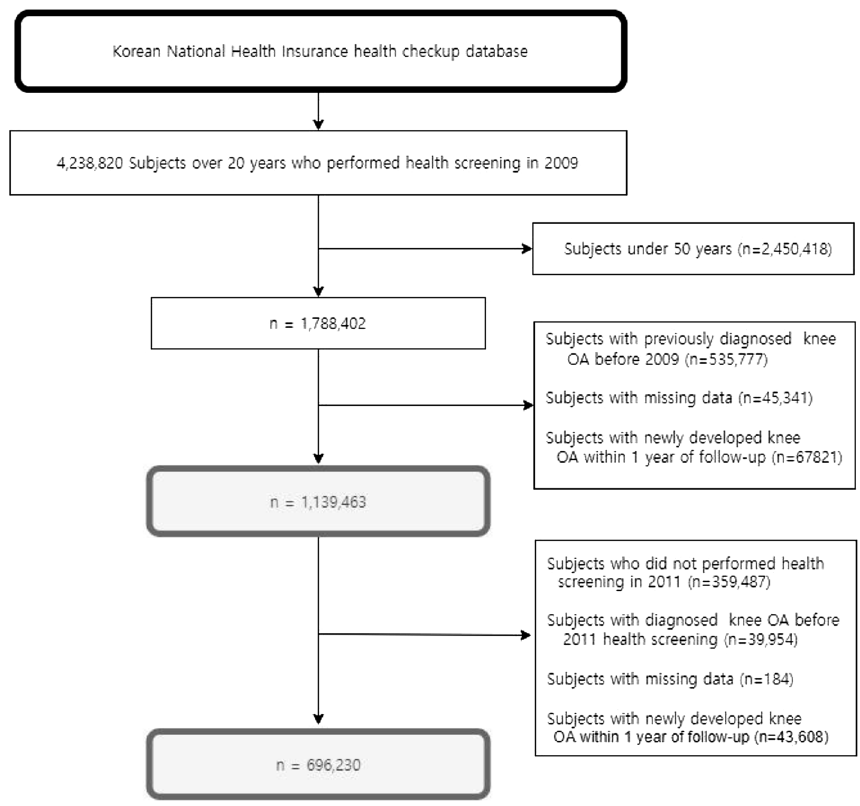
Figure 1. Flow chart of the cohort